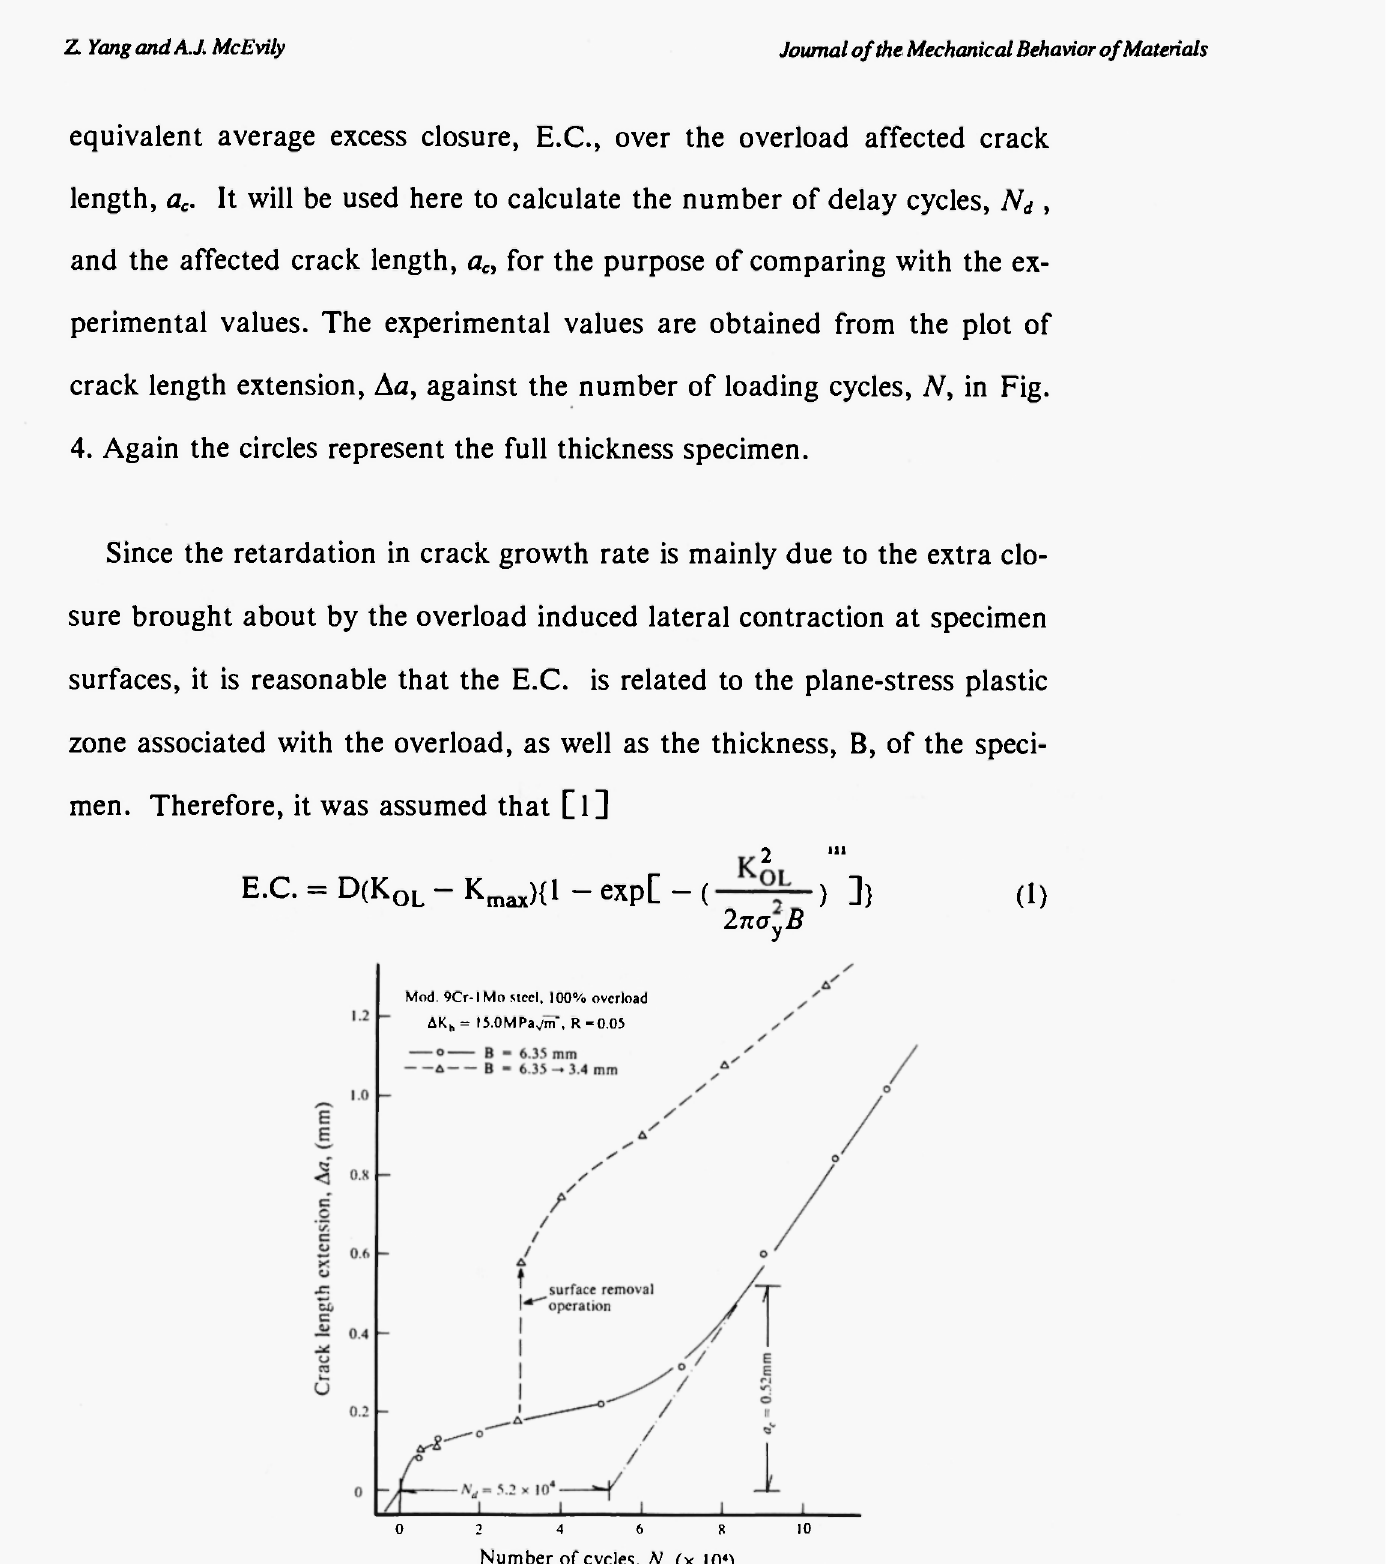
Figure 4. Variation of crack length increment with the number of loading cycles following 100% single overload for Mod. 9Cr-lMo